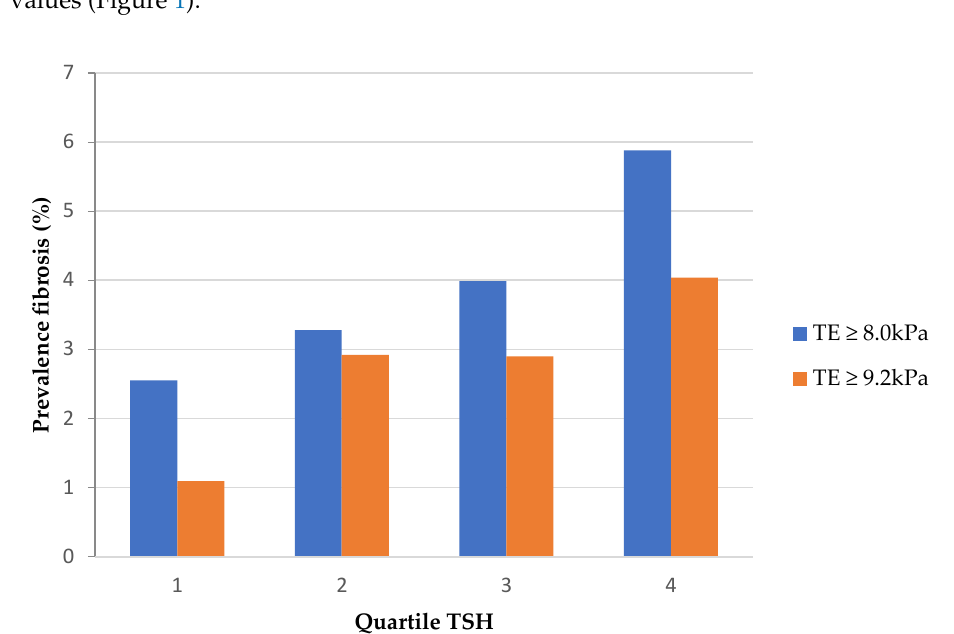
Table 2. Association between liver fibrosis according to thyroid function.